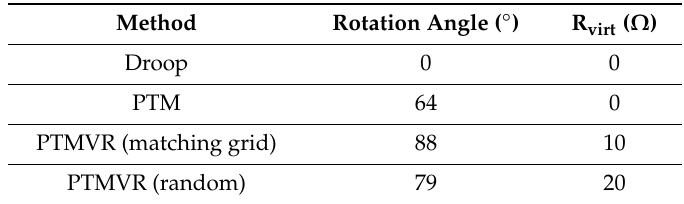
Figure 2. Generic flowchart for the power control methods under assessment. Table 2. Configuration parameters of control methods under assessment.